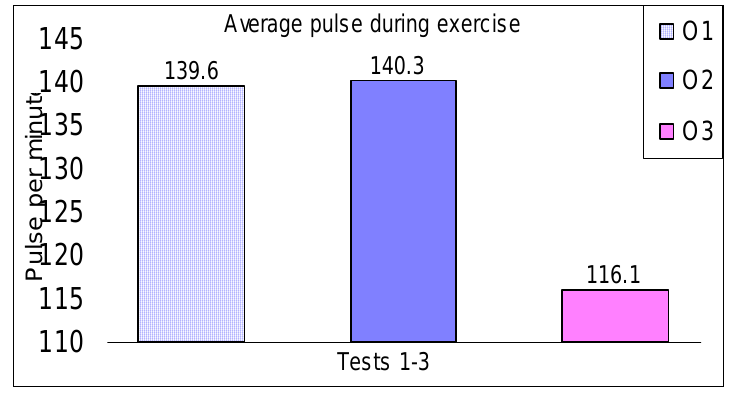
FIGURE 2 . Change in average pulse during exercise. The figure represents the average heart during exercise scores for all participants (n = 15) at tests O 1 (2 months